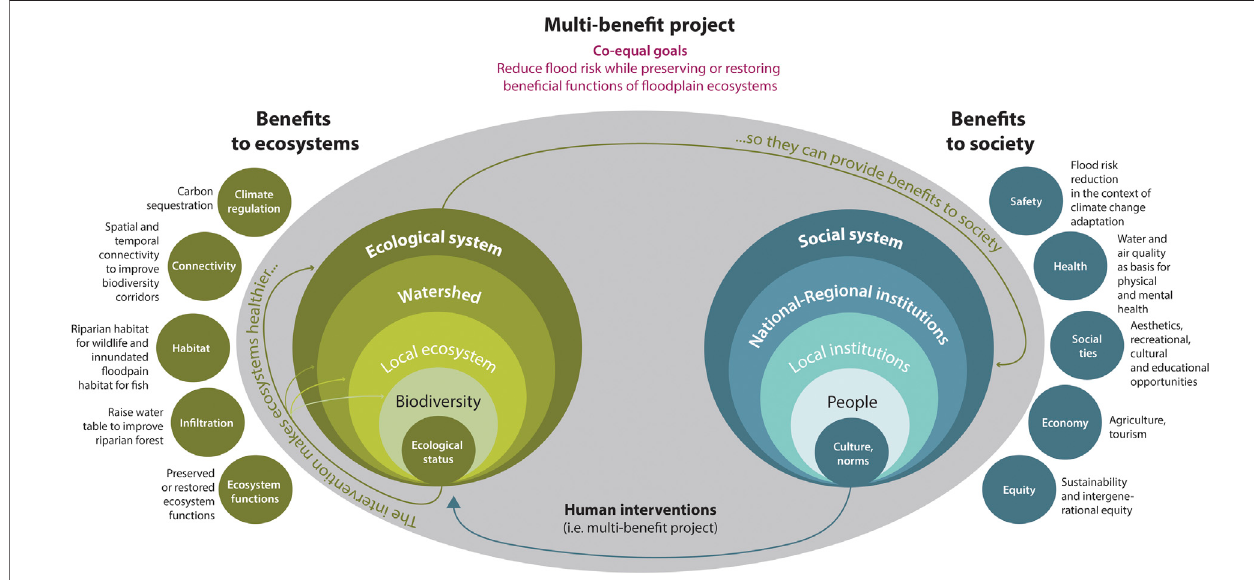
FIGURE2| Conceptualdiagramoftheroleofmulti-bene fi tprojectsinthecontextofsocial-ecologicalsystems(Source:modi fi edfromEEA(EuropeanEnvironment Agency), 2010).